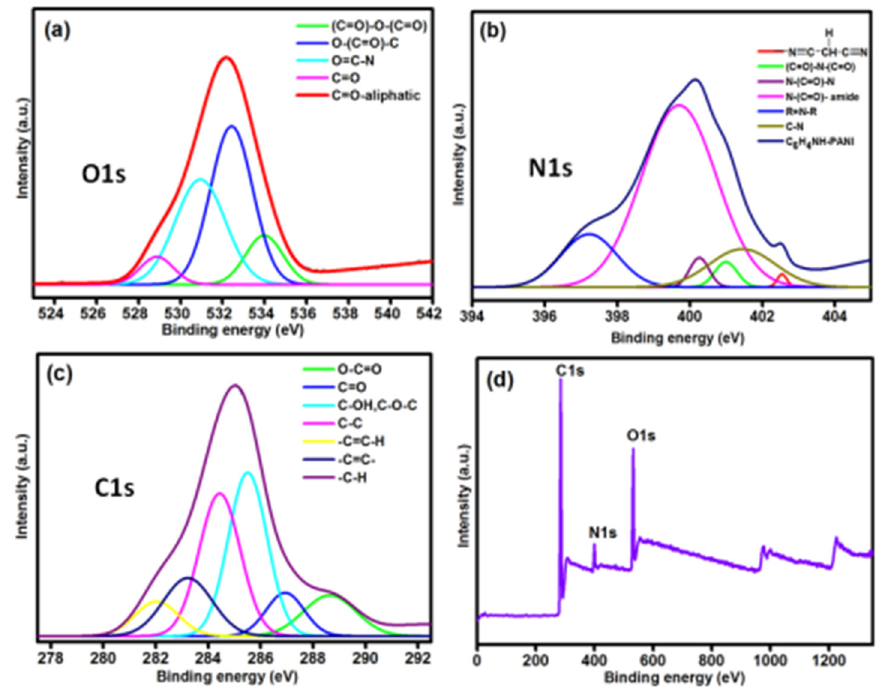
Figure 2. High-resolution O1s, N1s, and C1s ( a – c ) spectra; and ( d ) full XPS survey of PANI-